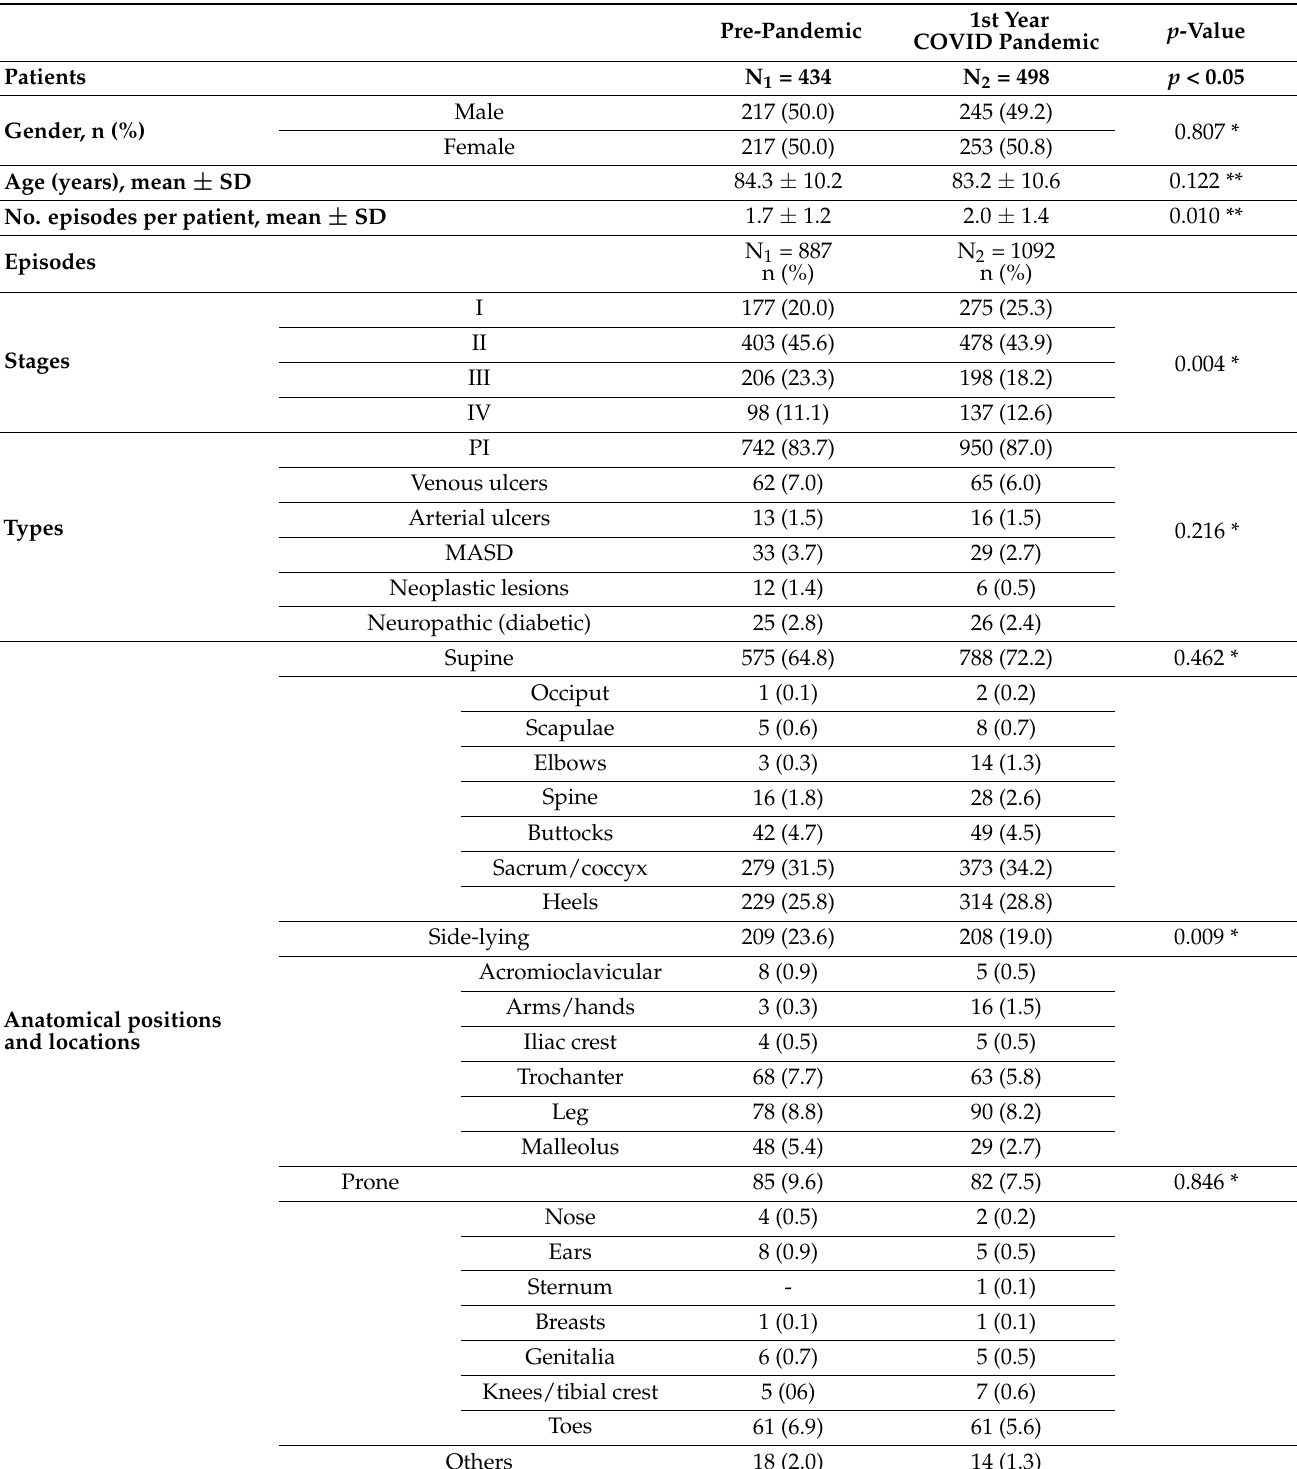
Table 2. Bivariate analysis testing the main clinical and epidemiological characteristics of skin wounds during pre-pandemic year versus first year of the COVID-19